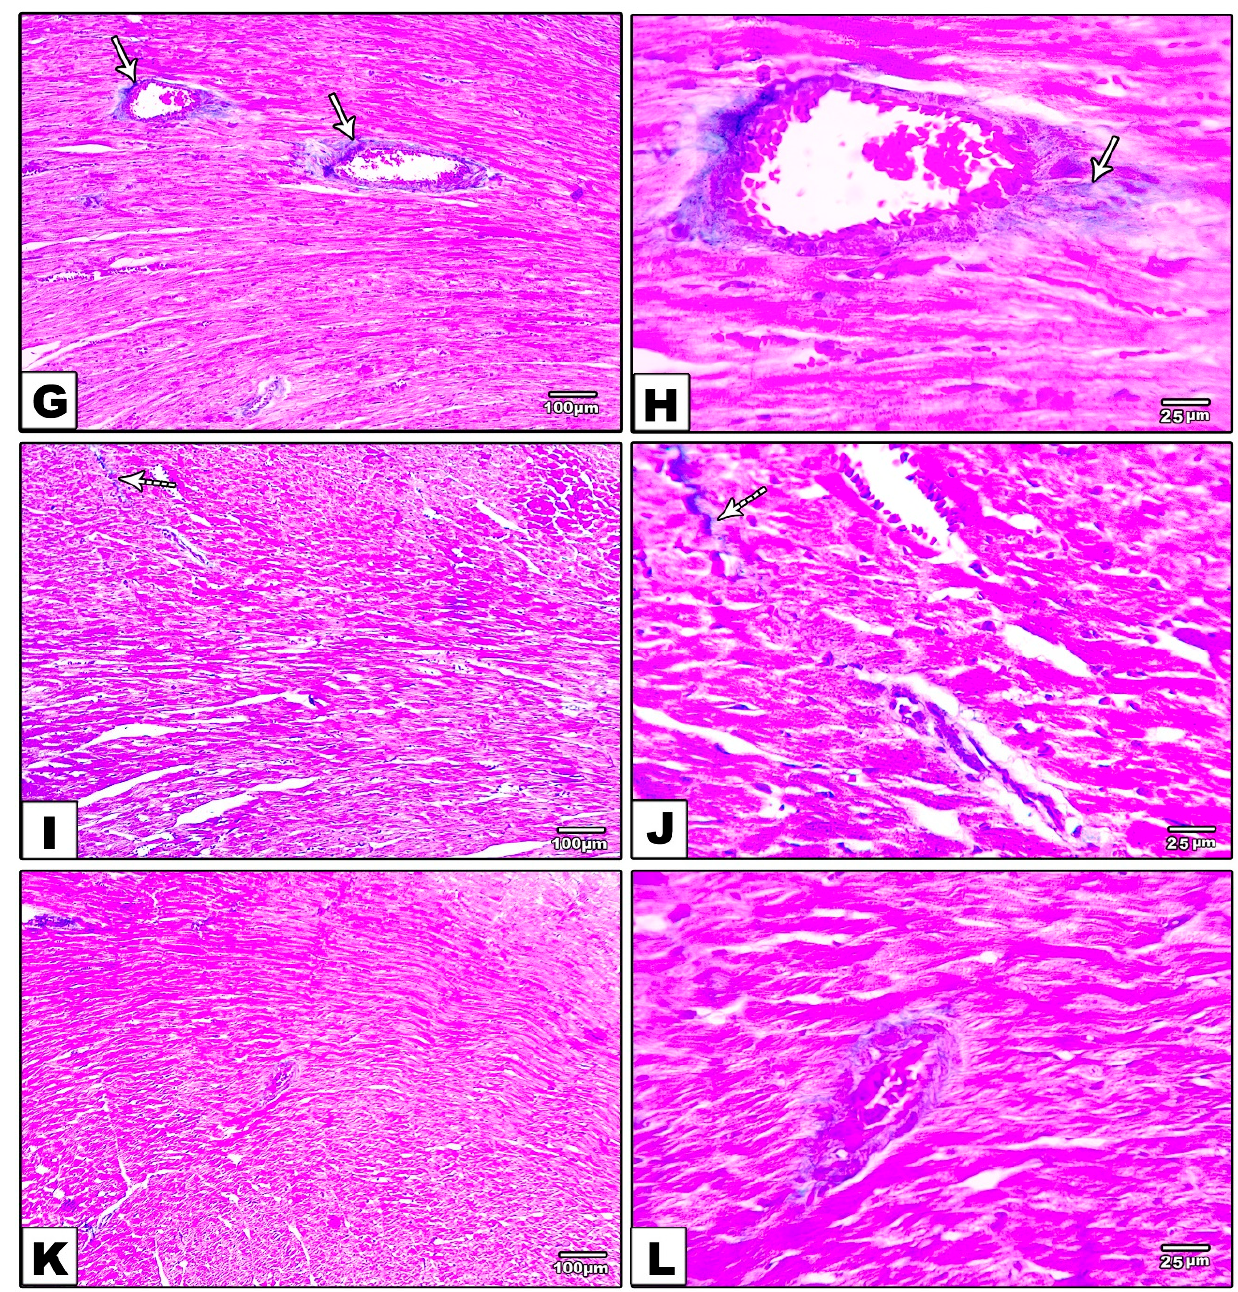
Figure 4. Masson trichrome stained sections. ( A , B ) control group showing no fibrosis, ( C – F ) DM group showing marked perivascular and interstitial fibrosis and collagen deposition (white arrow), ( G , H ) DM-S group showing moderate perivascular fibrosis and collagen deposition (white arrow), ( I , J ) DM-F group showing minimal interstitial fibrosis and collagen deposition (white arrow), and ( K , L ) DM-SF group showed nearly no fibrosis or collagen deposition.